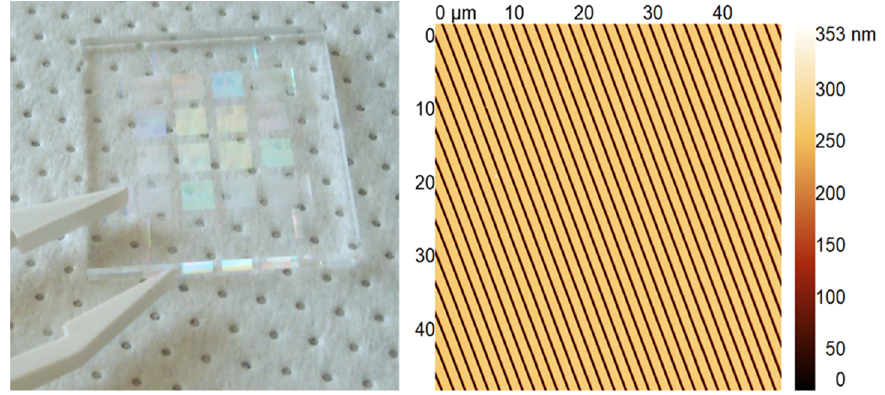
Figure 1. Left: photograph of the diffusor foil master. Right: AFM image of this master. The scan area is 50 × 50 µm².